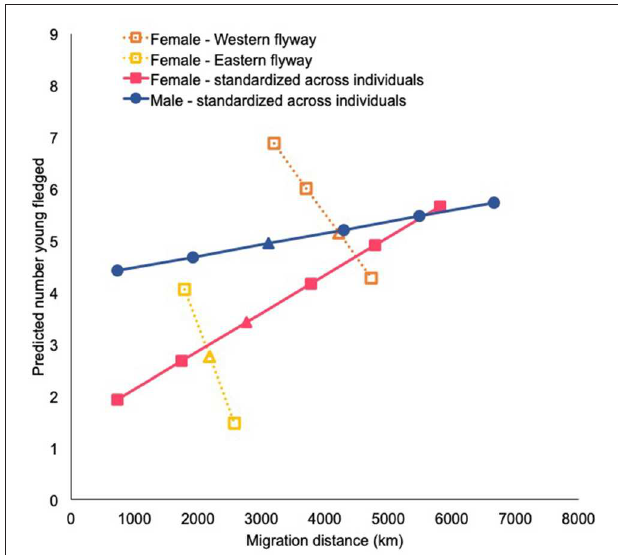
FIGURE 3 | Predicted number of young fledged by tree swallows based on migration distance. Predicted relationships from the path model standardized by flyway for females are shown with open squares and dashed lines, with the flyways separated (western = orange; eastern = yellow). Relationships from the path model standardized across individuals for females is indicated by the solid pink squares and lines. Males from the path model standardized across individuals are represented by filled blue circles and solid lines. Relationships were based on the path analyses ( Figure 2 ), and subsequent changes in young fledged (y-axis) are based on total effects of migration distance (x-axis) calculated from the path analyses. The triangle indicates the mean value of young fledged and migration distance in which each predicted relationship is based